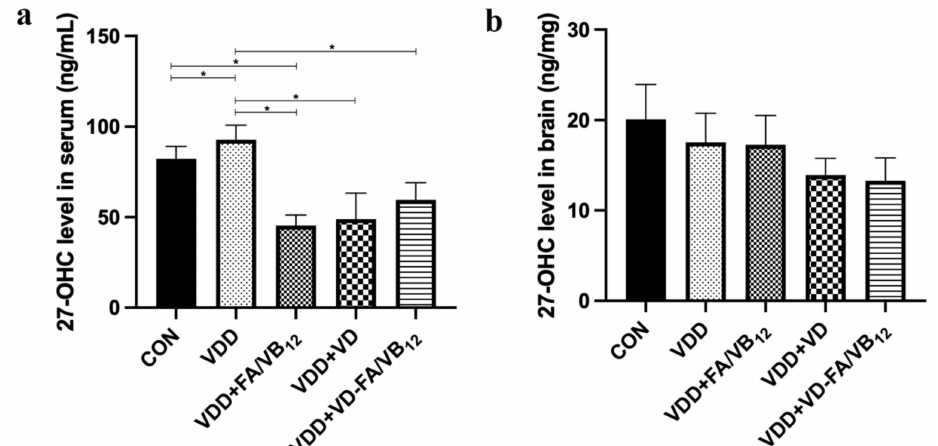
Figure 5. 27-OHC concentration in serum and brain. ( a ) 27-OHC level in serum; ( b ) 27-OHC level in brain. CON: control; VDD: vitamin D-deficient diet; VDD + FA/VB 12 : vitamin D-deficient diet plus folic acid/vitamin B 12 supplement; VDD + VD: vitamin D-deficient diet plus vitamin D supplement; VDD + VD-FA/VB 12 : vitamin D-deficient diet plus vitamin D and folic acid/vitamin B 12 . All data are presented as the mean ± SEM ( n = 3). A two-sided p < 0.05 was considered statistically